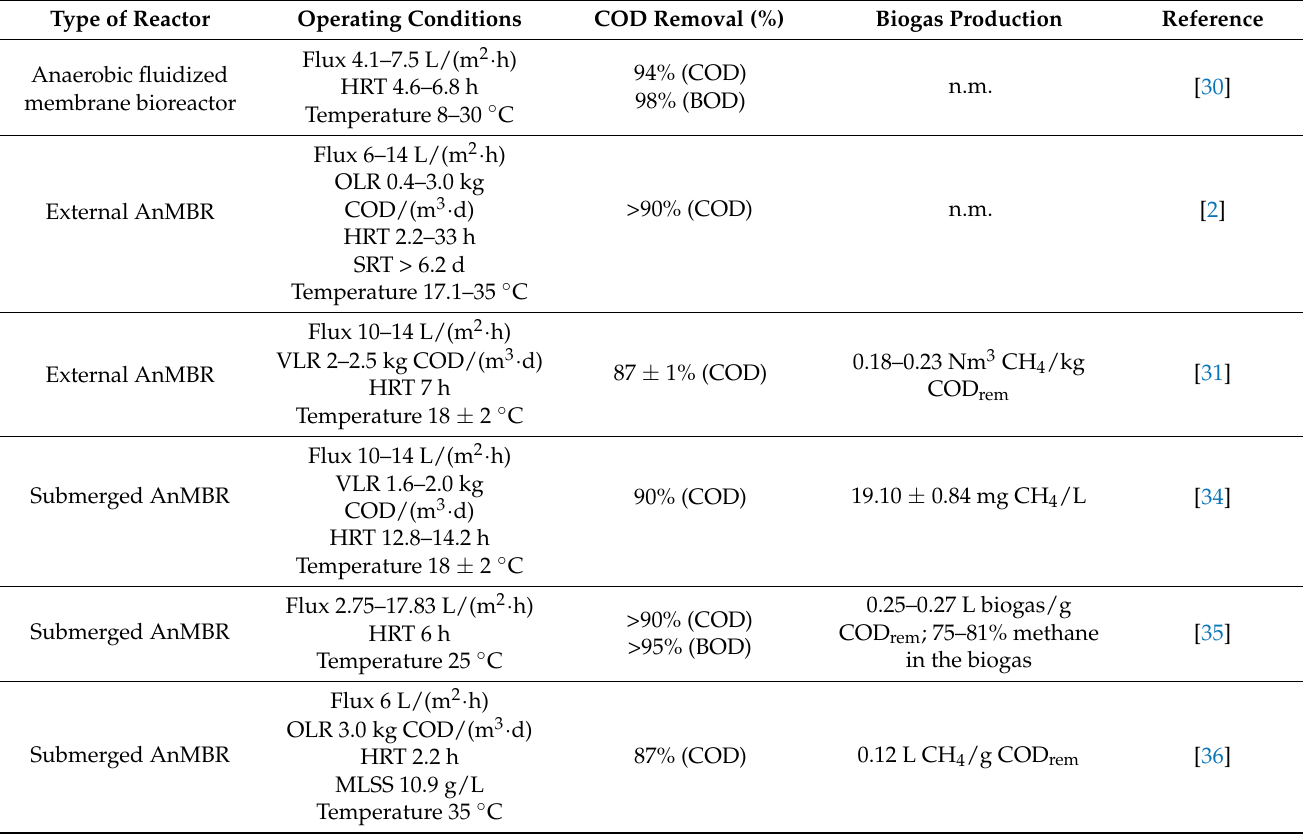
Table 2. Examples of AnMBR applications for the treatment of municipal